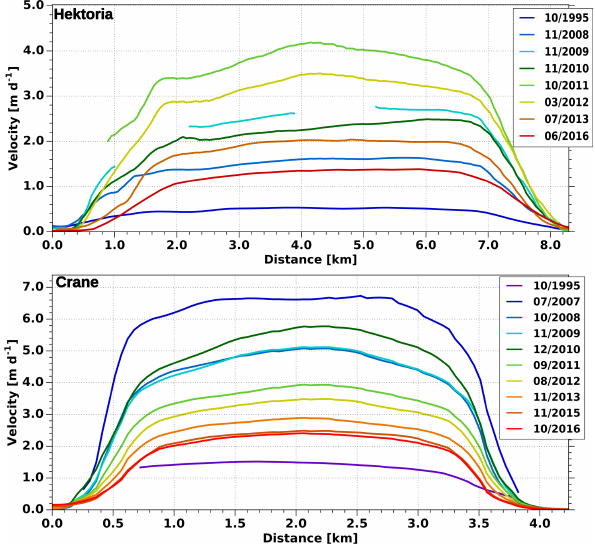
Figure 10. Surface velocity across the flux gate of Hektoria Glacier and Crane Glacier on different dates (month/year) between 1995 and